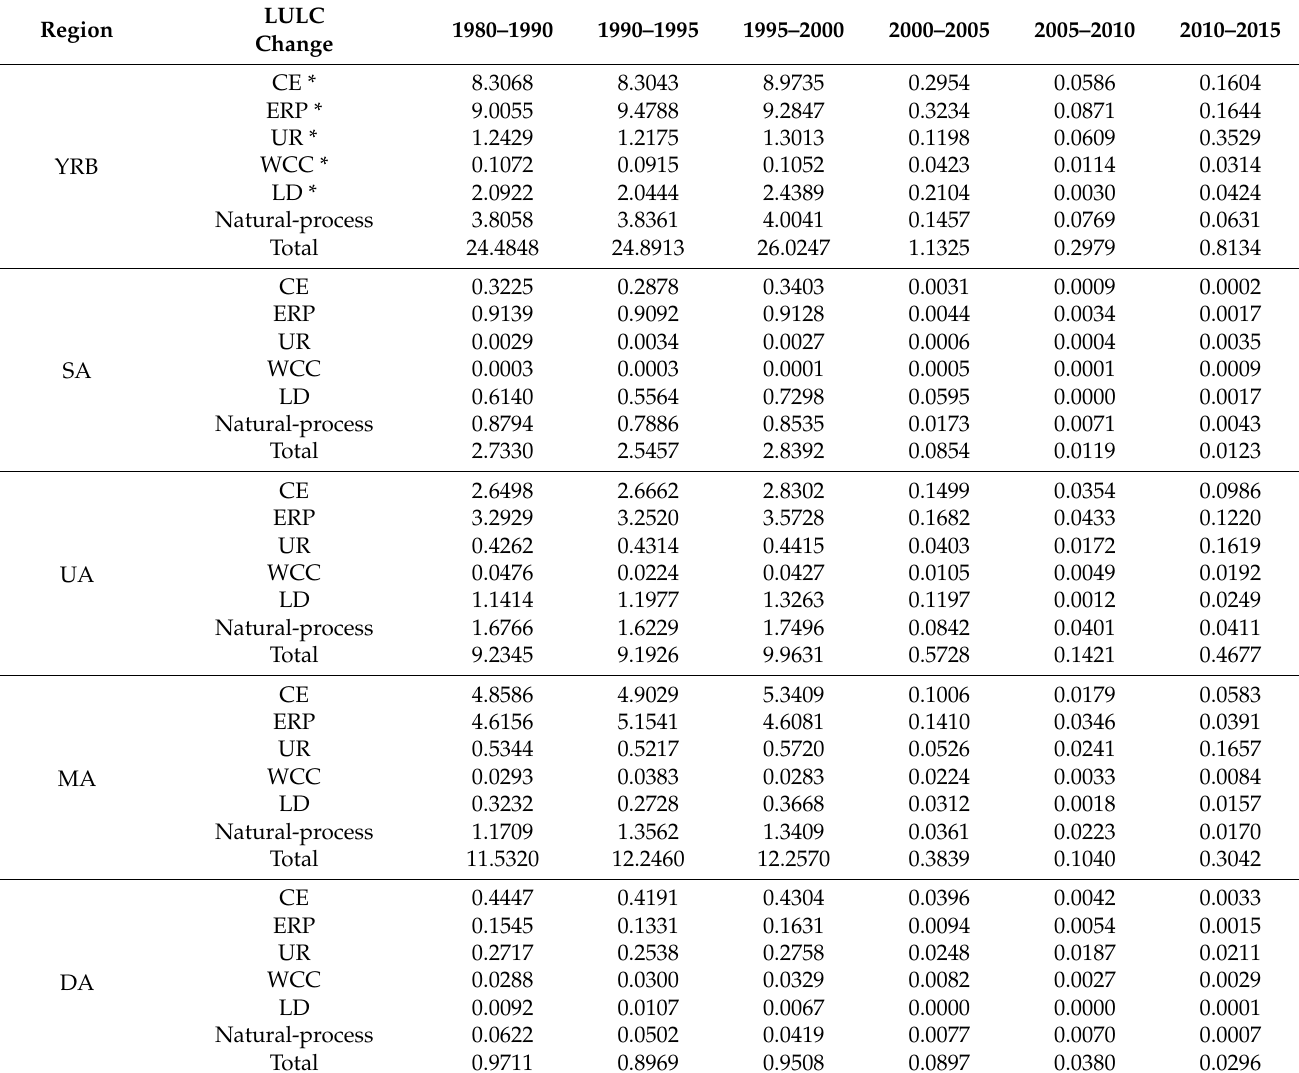
Table A4. LULC change area (M ha) in different periods.